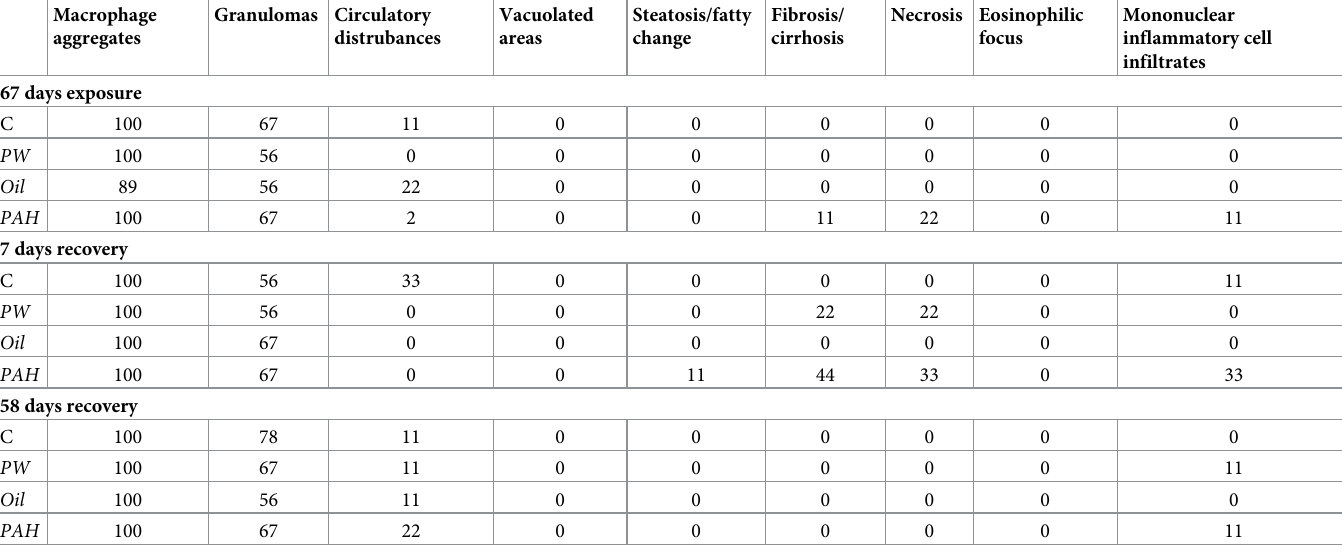
Table 6. Morphologic diagnostic results from histopathological examination of liver in haddock after 67 days of exposure, 7 days of recovery and 58 days of recovery.